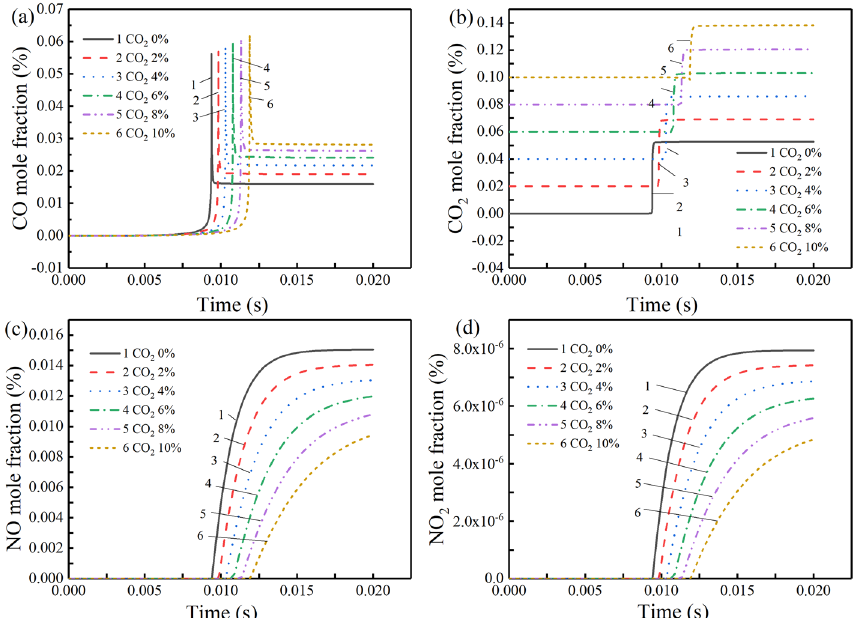
Figure 5. Variation of product concentration of some gases with time under different CO 2 volume fractions at 7% CH 4 : ( a ) CO, ( b ) CO 2 , ( c ) NO, and ( d ) NO 2 .